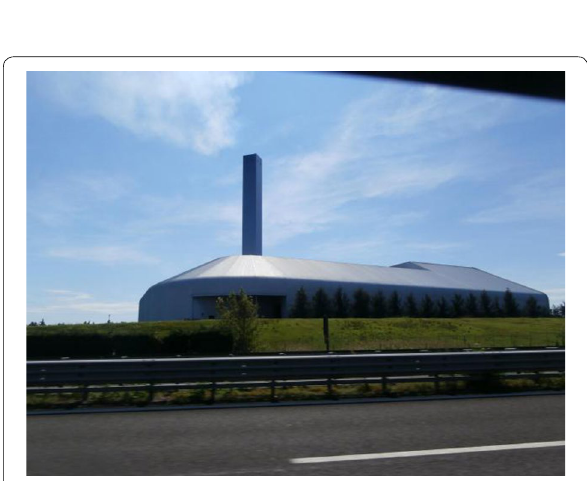
Fig. 22 Thermoelectric plant in Monfalcone, IT (from http://www.